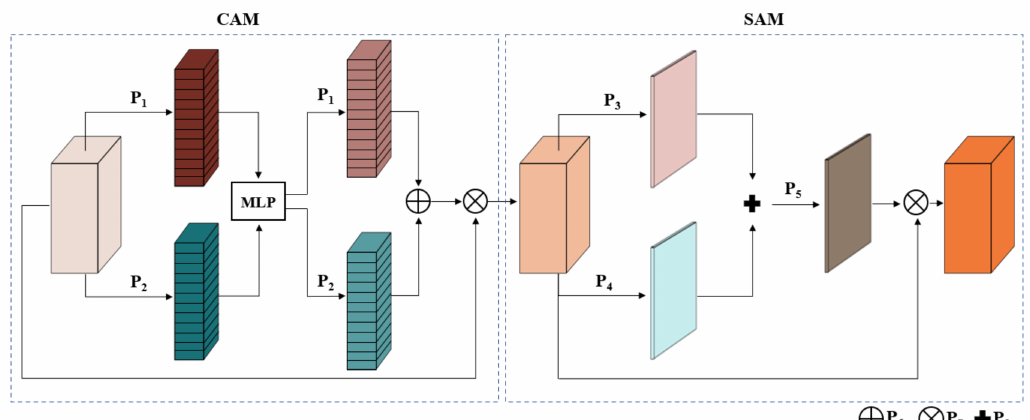
Figure 4. Channel attention module (CAM) and spatial attention module (SAM). P1: Maximum global pooling; P2: Global average pooling; P3: Maximum pooling of channels; P4: Average pooling of channels; MLP: Multilayer Perceptron; P5: The convolution kernel is 7 × 7 two-dimensional convolutions, followed by sigmoid activation function; P6: Element-wise addition; P7: Element-wise multiplication; P8: Channel merging.